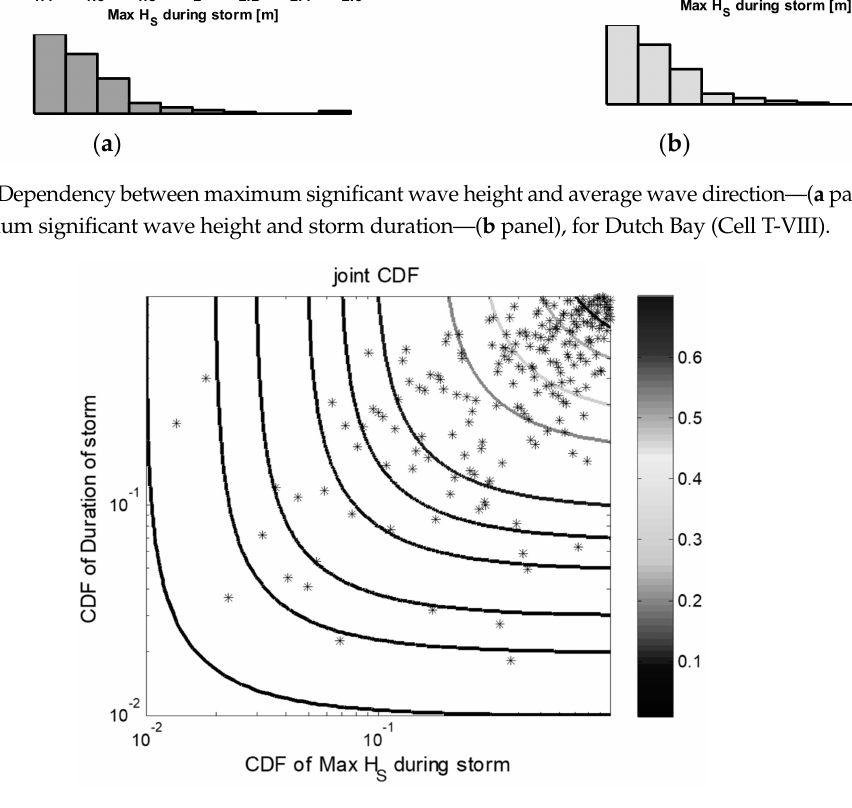
Figure 11. Joint probability model (JPM) of maximum significant wave height (m) and storm duration (Hour) for Dutch Bay (Cell